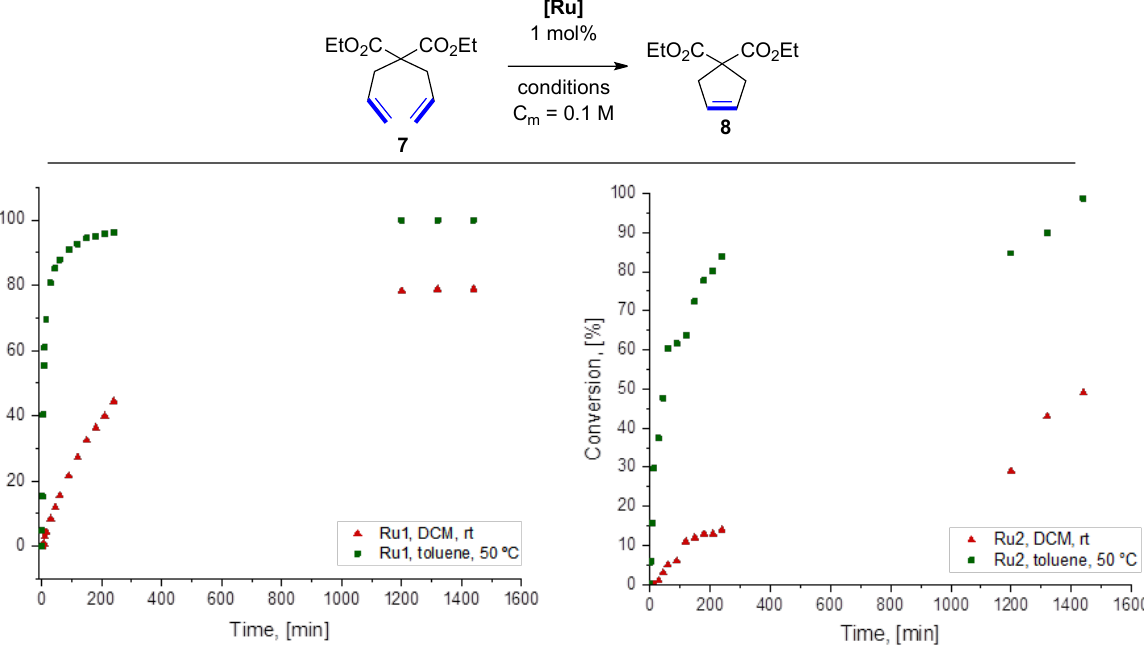
Figure 2. Time/conversion plot for the RCM reaction of 7 (0.1 M) catalysed by Ru1 and Ru2 (1 mol%) in DCM at 23 °C and in toluene at 50 °C. Conversion determined through GC.